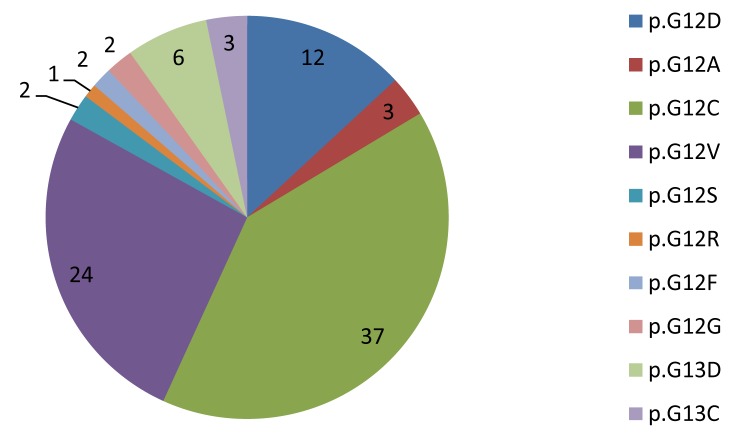
Schematic representation of the distribution (%) of different KRAS mutations.